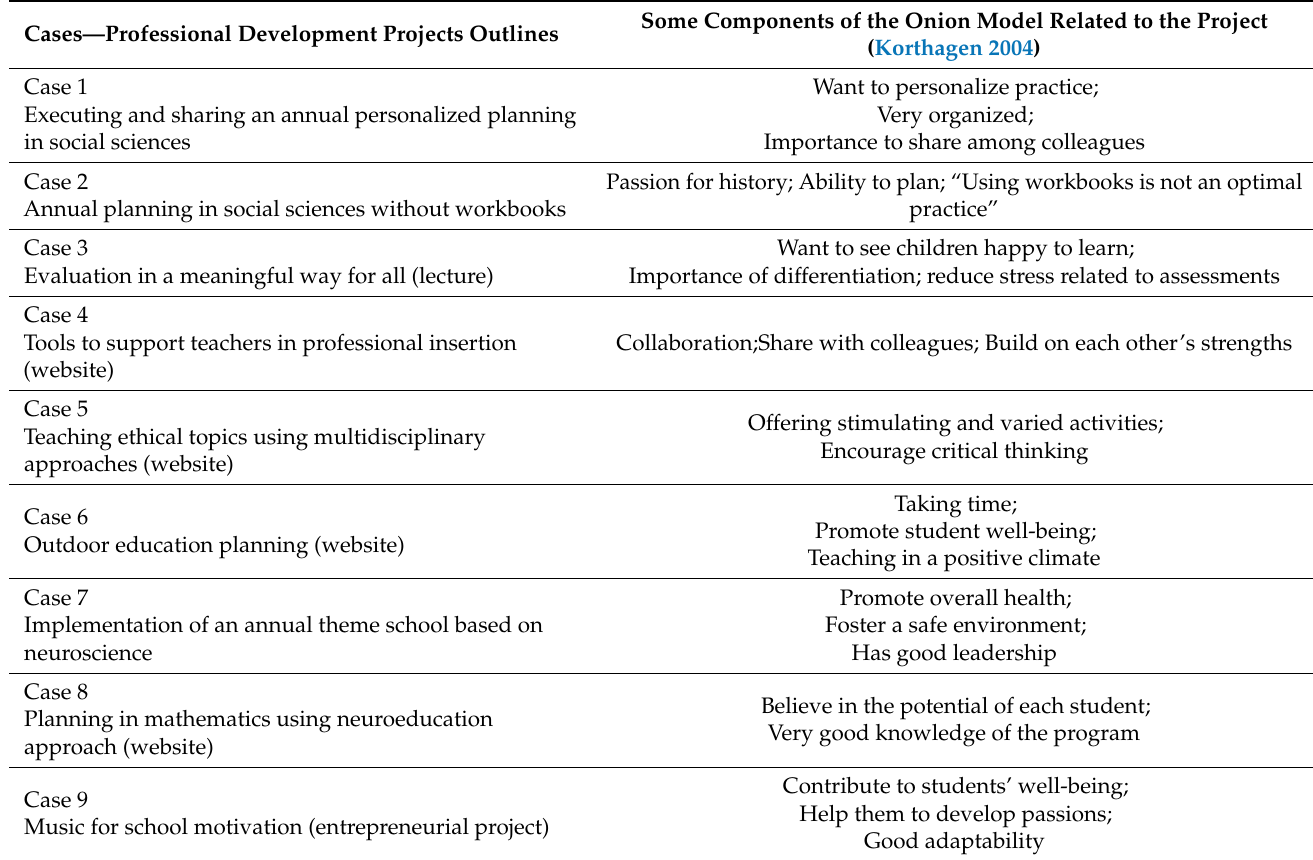
Table 2. Professional Development Project and Onion Model Components